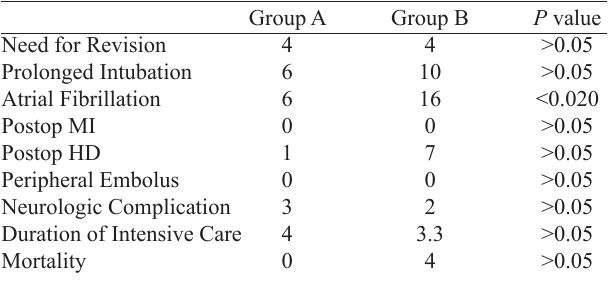
Table 4. Comparison of number of Group A and Group B patients according to postoperative parameters.